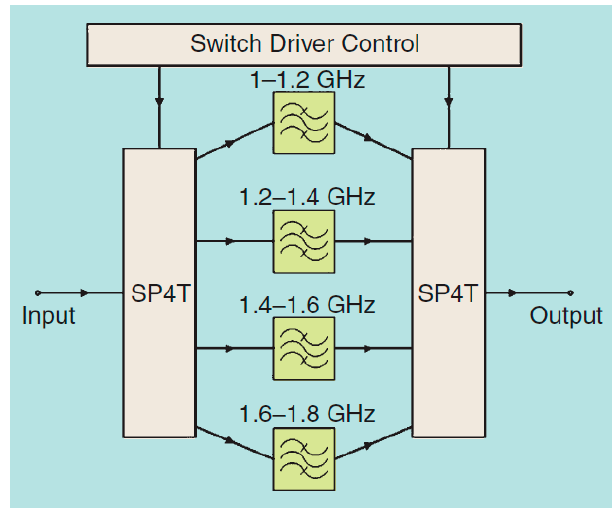
Figure 10. Electronically-tuned reconfigurable filters [60].